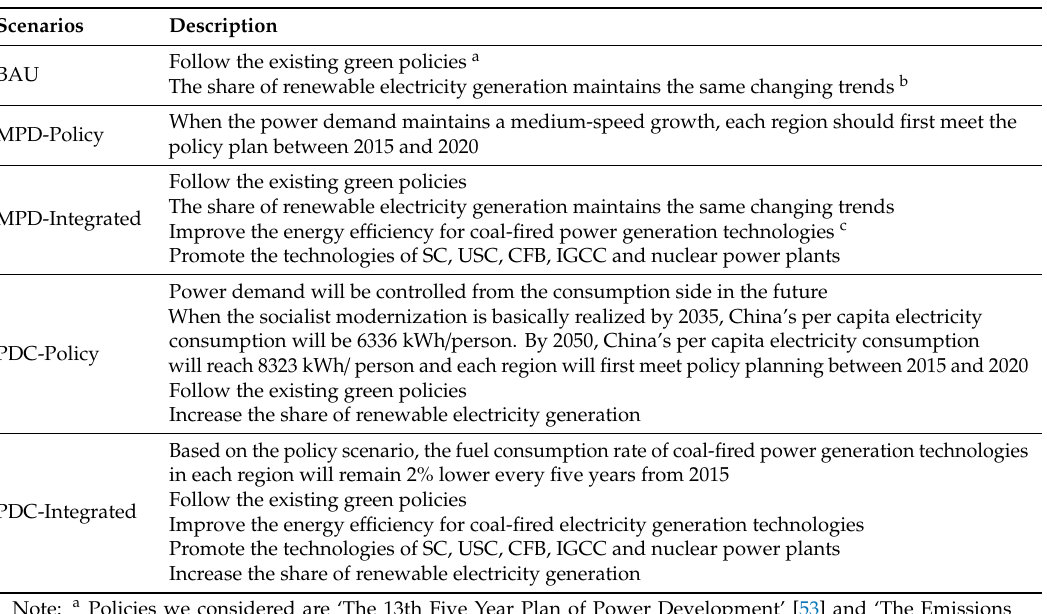
Table 3. Scenario descriptions in the power